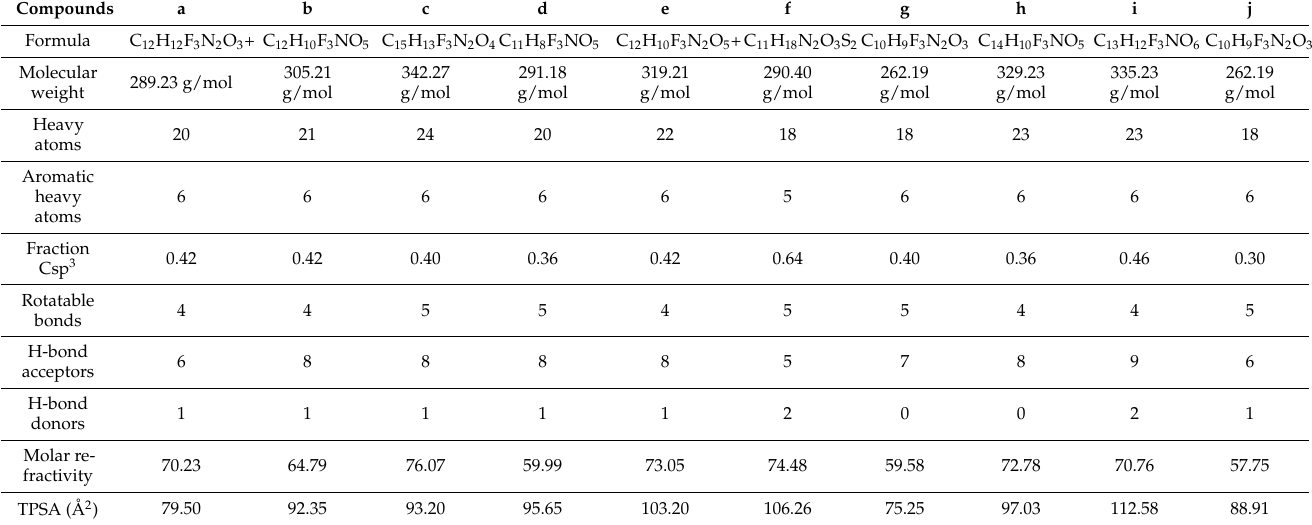
Figure 9. According to the boiled egg, all the selected best hits do not cross the blood–brain barrier (BBB) and have high gastrointestinal permeability. Table 3. ADME analysis of the screened hits after molecular docking via SeeSAR.